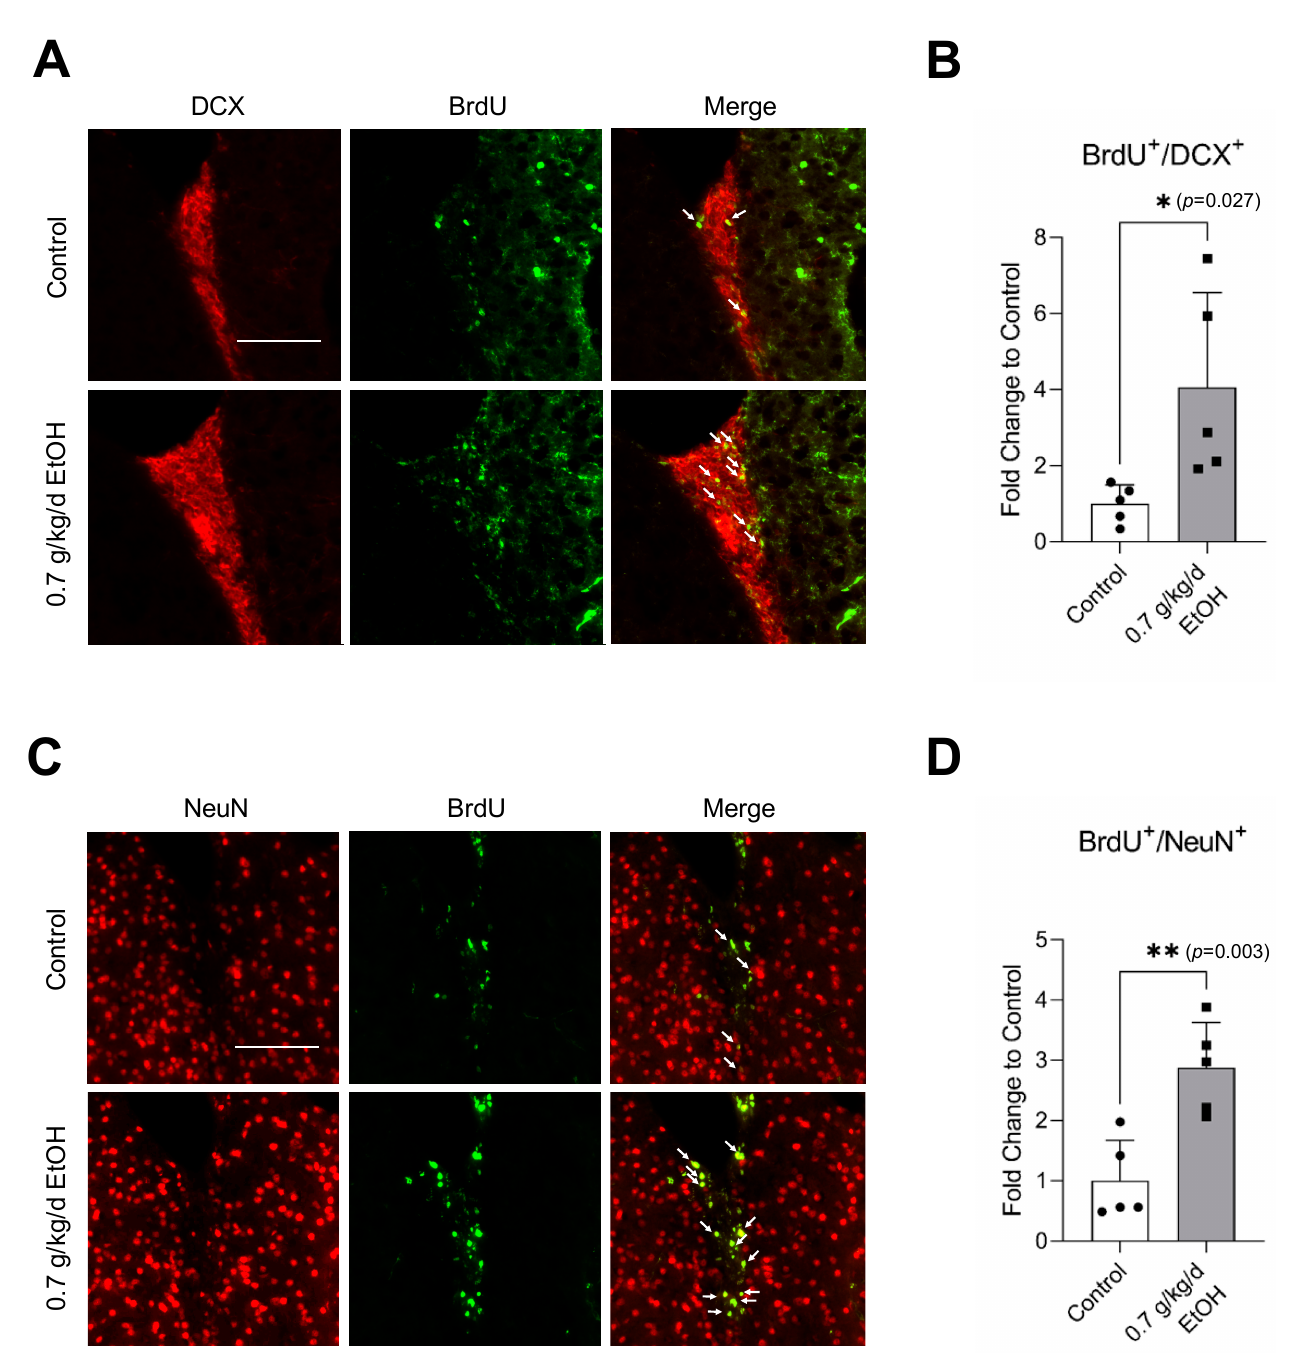
Figure 4. Effect of LAC on postischemic neurogenesis in the SVZ. ( A ) Representative double staining of BrdU and DCX. Scale bar = 100 µm. ( B ) Values are means ± SD ( n = 5). ( C ) Representative double staining of BrdU and NeuN. ( D ) Values are means ± SD ( n = 5); * p < 0.05; ** p < 0.01 vs. Control. Analyzed using an unpaired t -test.